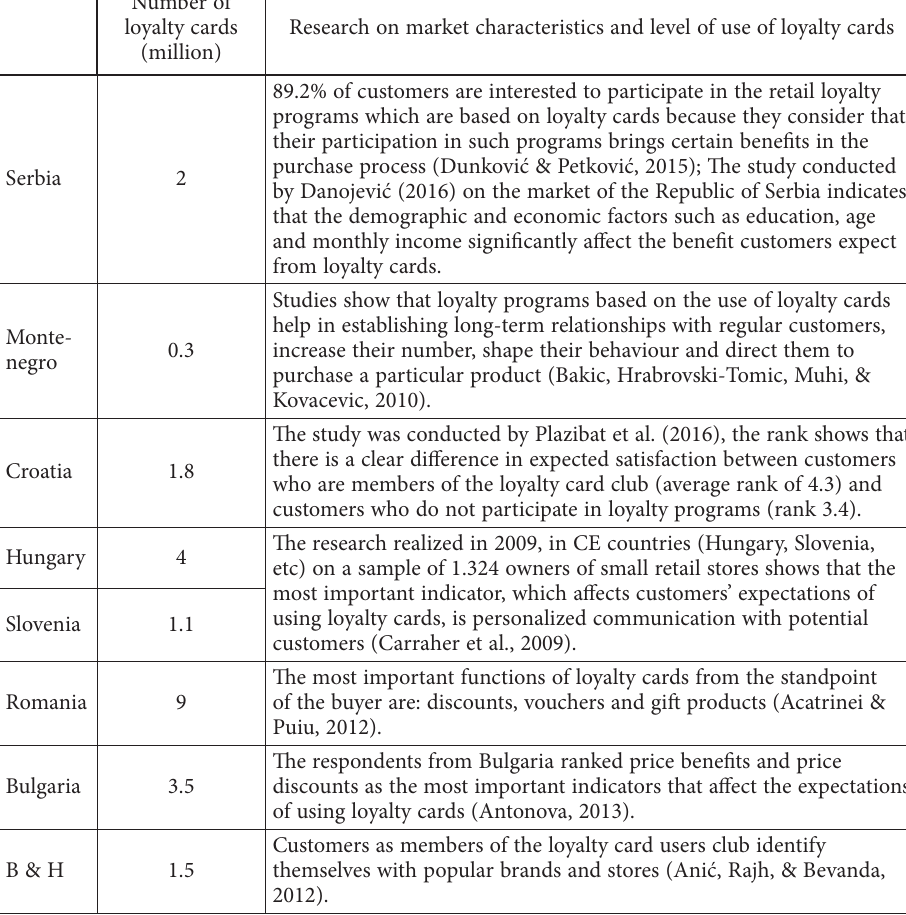
Table 2. Comparative overview of selected CE and SEE countries Number of loyalty